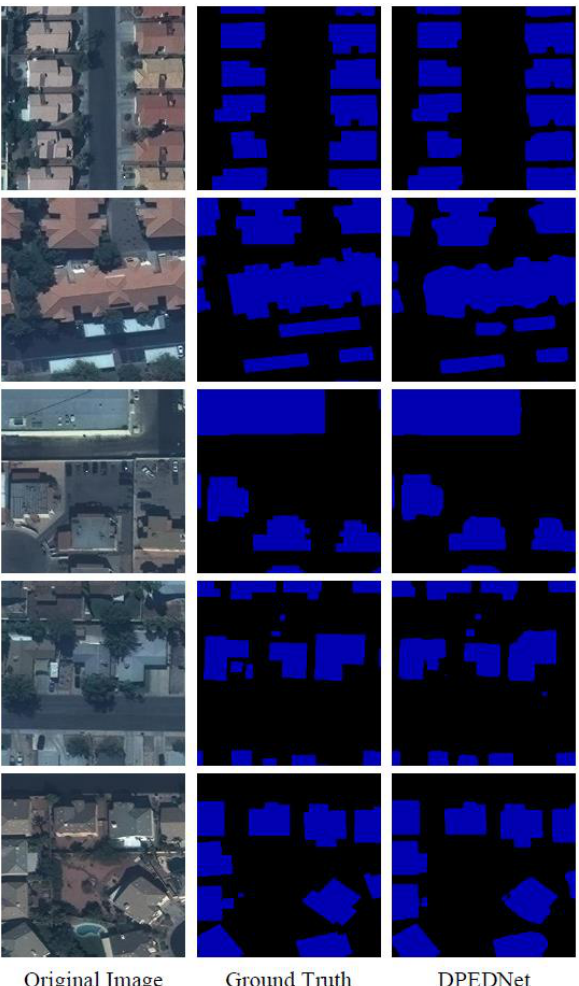
Figure 3. Qualitative examples of the segmentation results on Crowed mapping challenge